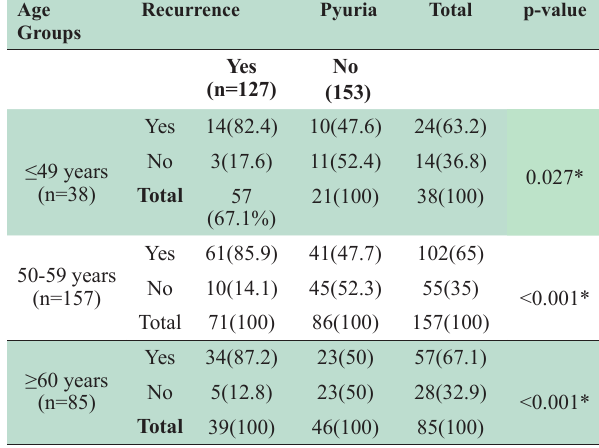
Table-VI: Comparison of Tumor Recurrence between Patients with and without Pre-operative Pyuria across Age Groups